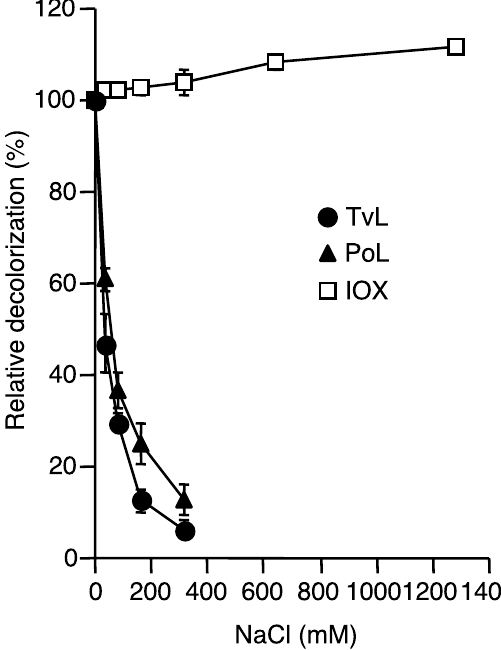
Figure 5. Effect of sodium chloride concentration on Orange G decolorization activity by TvL, PoL, and IOX. The reaction condition was same as described in the legend of Fig. 5. The reaction time was 2 h. Percentages decolorization at relative decolorization of 100% by TvL, PoL, and IOX were 64%, 75%, and 87%, respectively.